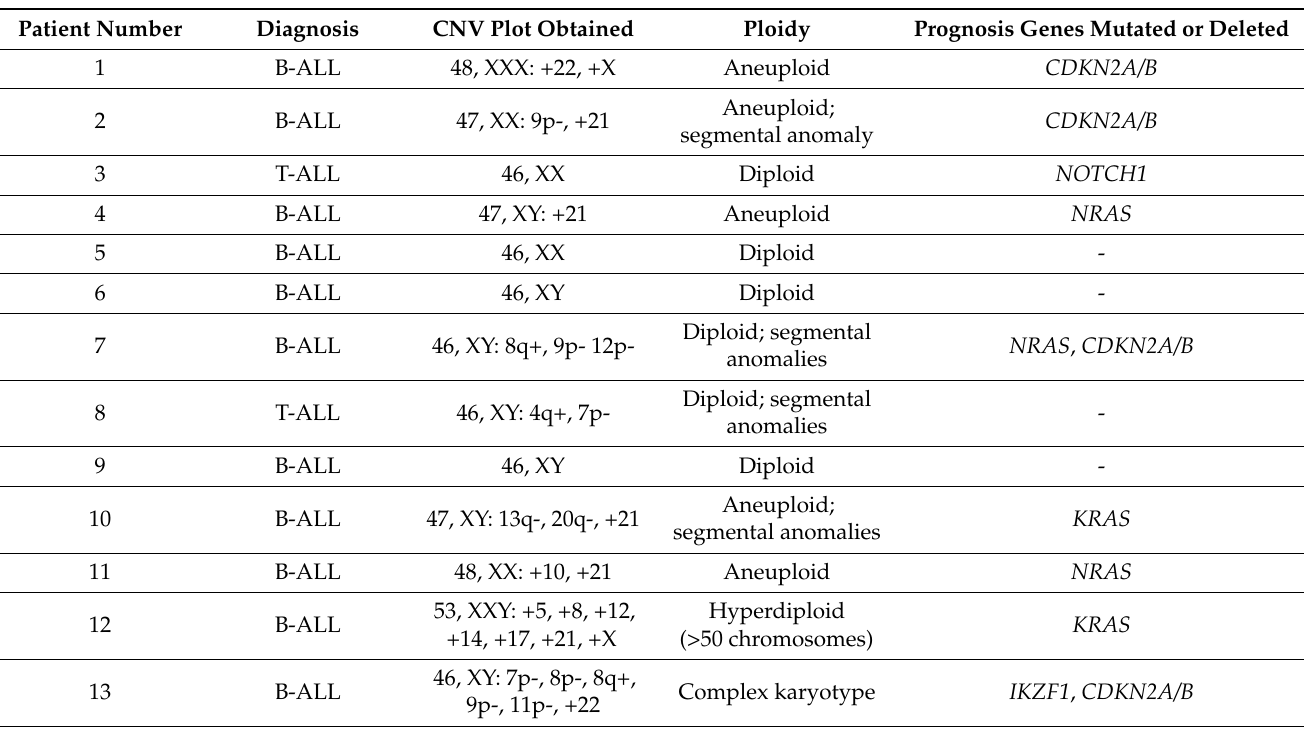
Table 3. Ploidy and distribution of mutations in TP53 , PTEN , NOTCH1 , KRAS , NRAS , FBXW7 , dele- tions IKZF1 , CDKN2A/B , TP53 , and gene fusions BCR-ABL1 , E2A-PBX1 and KMT2A rearrangements in 13 ALL samples.